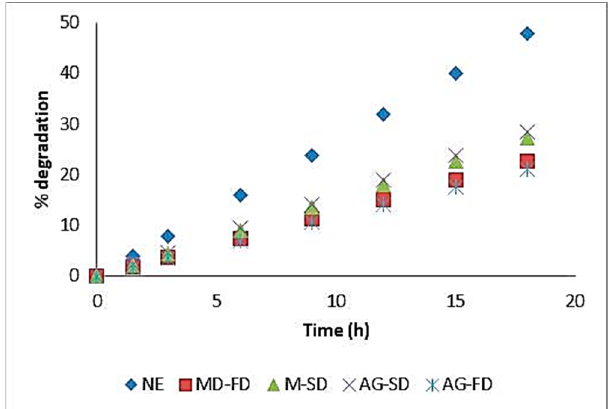
Figure 8. Degradation (%) kinetics in function of time (hours) for the red dye extract non-encapsulated (NE) and extracts encapsulated with maltodextrin (MD) and Arabic gum (AG) obtained by freeze-drying (FD) and by spray-drying (SD) (mean ± SD), at 80 °C.